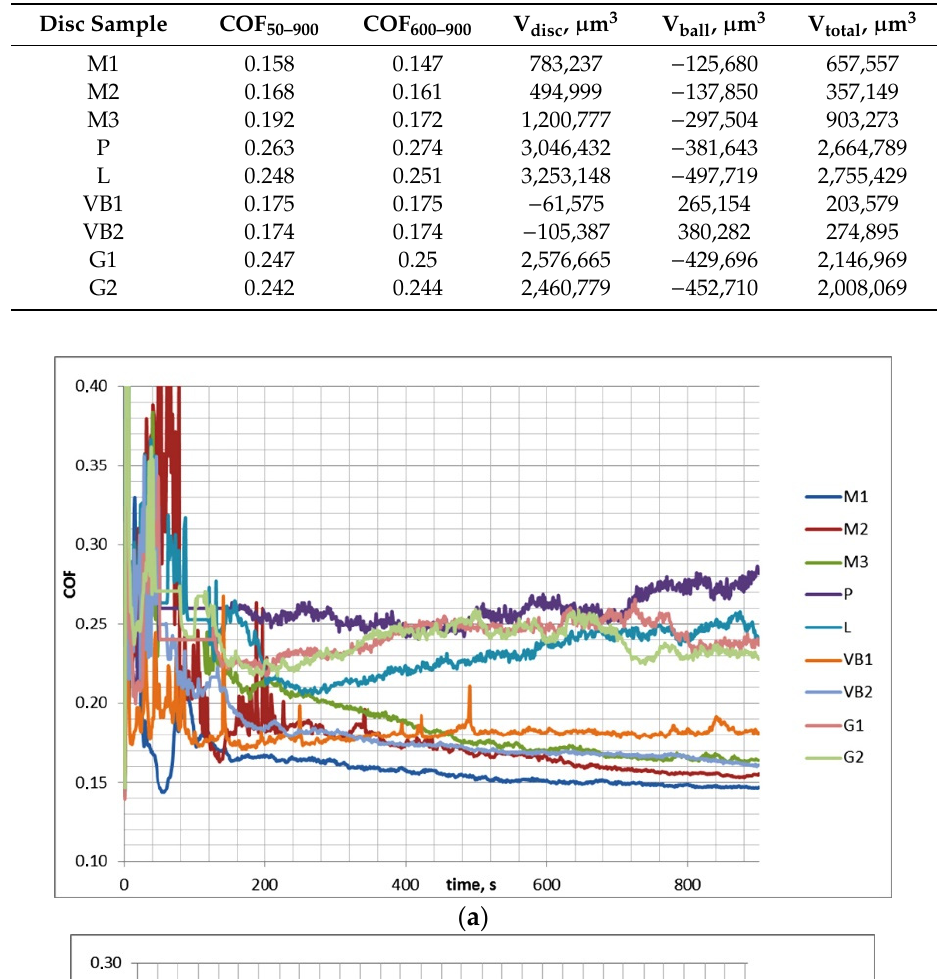
Table 4. Results of test B (f = 80 Hz, P = 45 N, temperature 90 °C, the number of cycles 72,000).